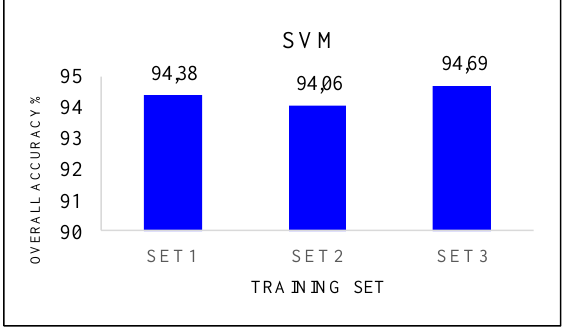
Figure 4. SVM classification and training set